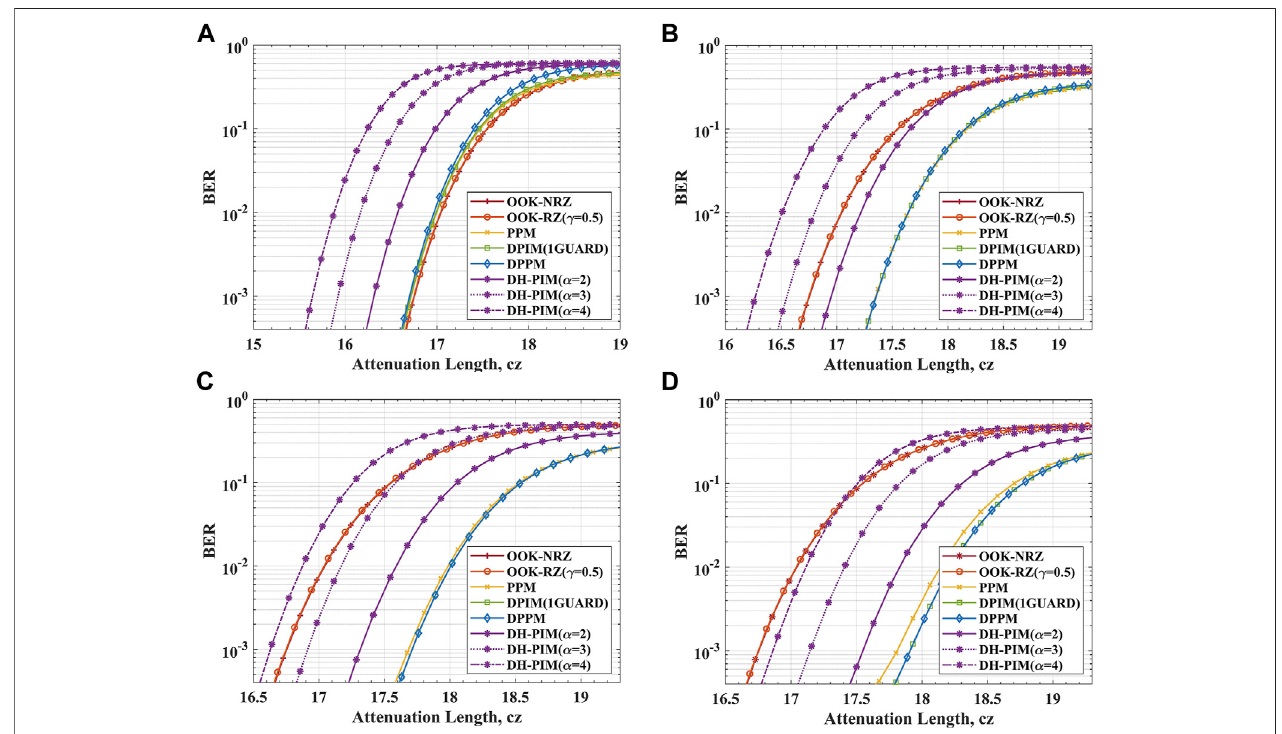
FIGURE5| TheBERagainst theattenuationlength forUPCCsysteminthepureseawaterchannel when thebitrateis50 Kbps. Thecommunicationperformance of UPCC systems under several modulation schemes when (A) M = 2 and (B) M = 4, (C) M = 6, (D) M = 8, respectively.